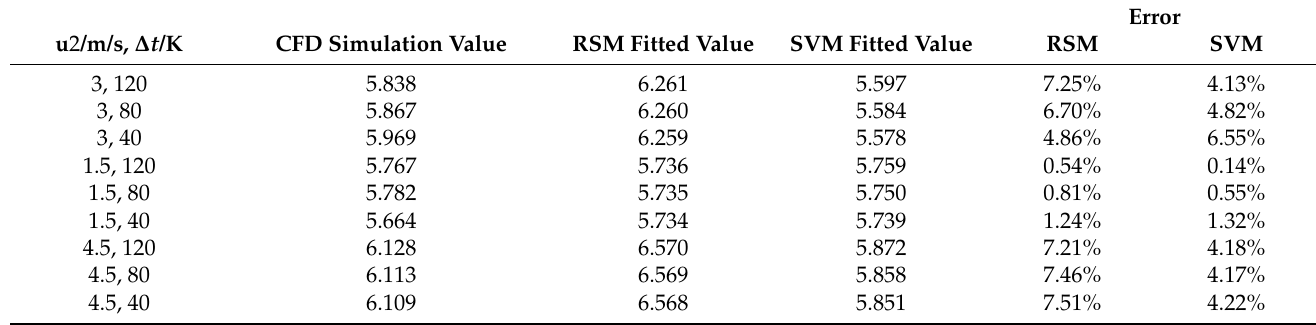
Table 8. Verification results of the fitting